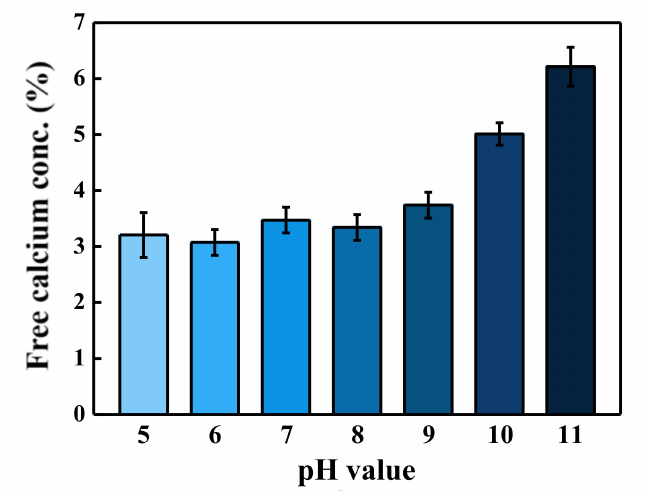
Figure 4. Free calcium concentration of TCP/ACP mixed powder at different pH values. The TCP/ACP mixed powder showed a stable amount of free calcium release with an average concentra- tion of 3.4% in the pH 5 to pH 9 range.